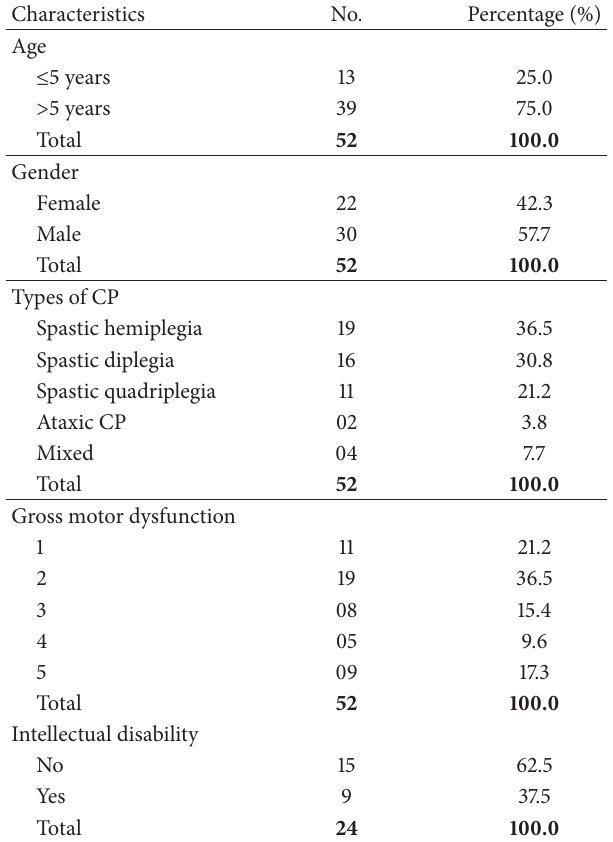
Table1:Somedemographiccharacteristics,GMFCS,andIntelligent Quotients of subjects with